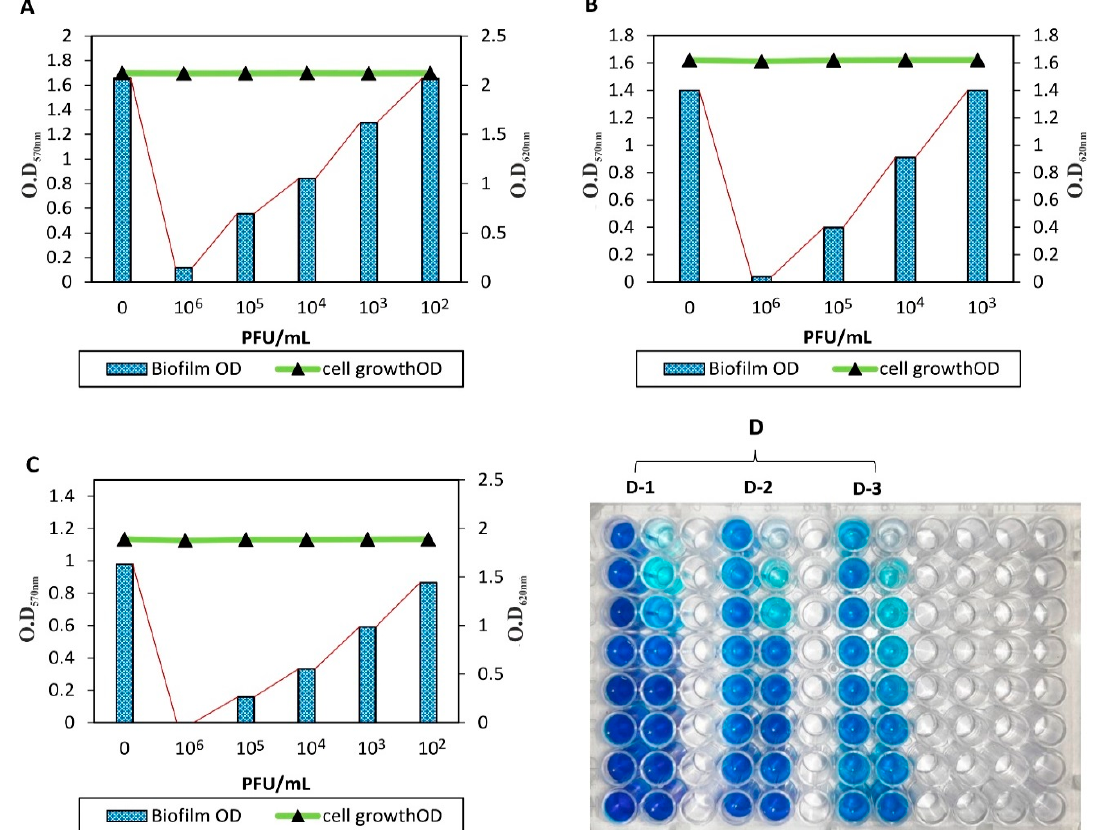
Figure 6. Qualitative anti-biofilm activity of CoNShP-3 phage in 96-well microplate. ( A ) S. epidermidis CFS79 biofilms. ( B ) S. haemolyticus CFS43 biofilms. ( C ) S. saprophyticus CFS28 biofilms. ( D ) 96-tissue culture plate [D-1, wells of biofilm control (left), and wells of anti-biofilm (right) of S. epidermidis CFS79; D-2, wells of biofilm control (left), and wells of anti-biofilm (right) of S. haemolyticus CFS43; D-3, wells of biofilm control (left), and wells of anti-biofilm (right) of S. saprophyticus CFS28].